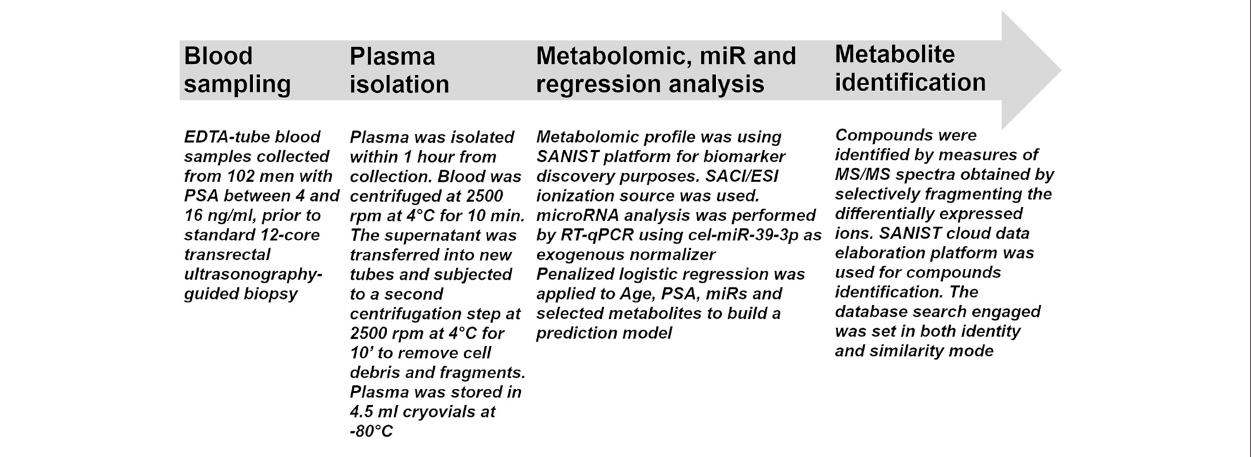
FIGURE 1 | Flow chart for sample processing. The fl ow chart indicates all the procedures performed in the study from sample collection to metabolite identi fi